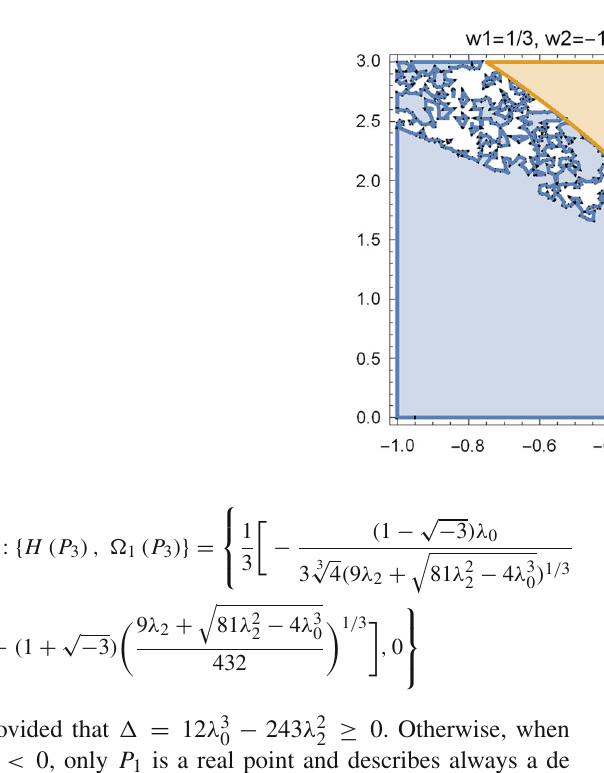
Fig. 2 Plot of the region in the space { λ 0 ,λ 2 } where the eigenvalues of the linearized system (19 ), (20) are negative. The first line is for w 1 = 0 and w = 1 , while the second line is 2 3 and w 2 = 0. The for w 1 = 1 3 plots in the left column corresponds to the point P 1 , and the plots in the right column to the point P 2 . The points are stable only when the colored areas